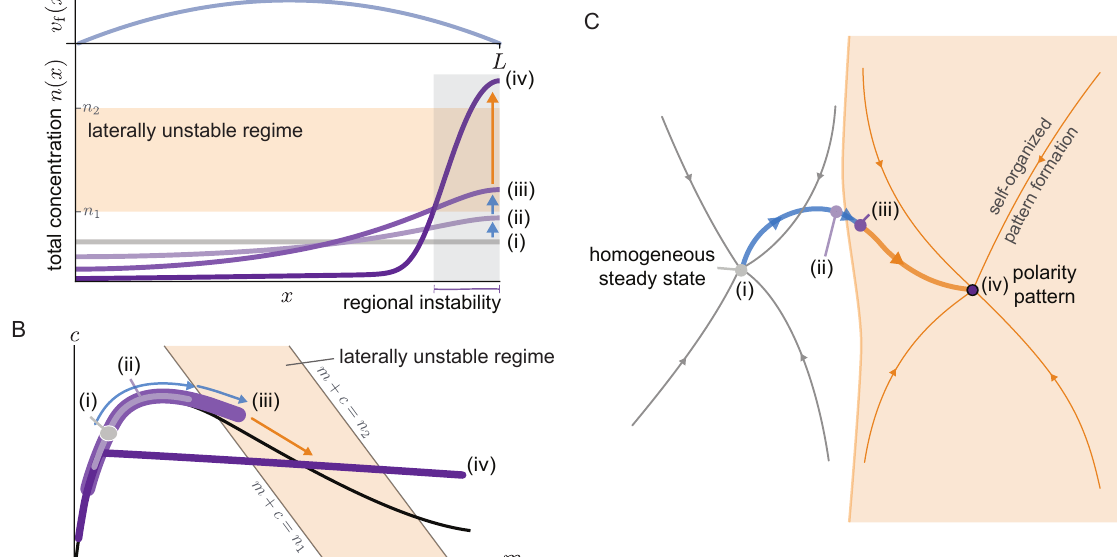
Figure 6. Flow-driven protein mass accumulation can induce pattern formation by triggering a regional lateral instability. ( A ) Top: quadratic flow velocity profile: v f ( x ) / v max = 1 − 4 ( x / L − 1/2 ) 2 . Bottom: illustration of the total density profiles at different time points starting from a homogeneous steady state ( i ) to the final pattern ( iv ); see Movie 5. Mass redistribution due to the non-uniform flow velocity drives mass towards the right hand side of the system, as indicated by the blue arrows. The range of total densities shaded in orange indicates the laterally unstable regime determined by linear stability analysis. Once the total density reaches this regime locally, a regional lateral instability is triggered resulting in the self-organized formation of a peak (orange arrow). ( B ) Sketch of the phase space representation corresponding to the profiles shown in A. Note that the concentrations are slaved to the reactive nullcline (black line) until the regional lateral instability is triggered. ( C ) Schematic representation of the state space of concentration patterns in a case where both the homogeneous steady state and a stationary polarity pattern are stable. Thin trajectories indicate the dynamics in the absence of flow and the pattern’s basin of attraction is shaded in orange. The thick trajectory connecting both steady states shows the flow-induced dynamics, corresponding to the sequence of states ( i )–( iv ) shown in A and B